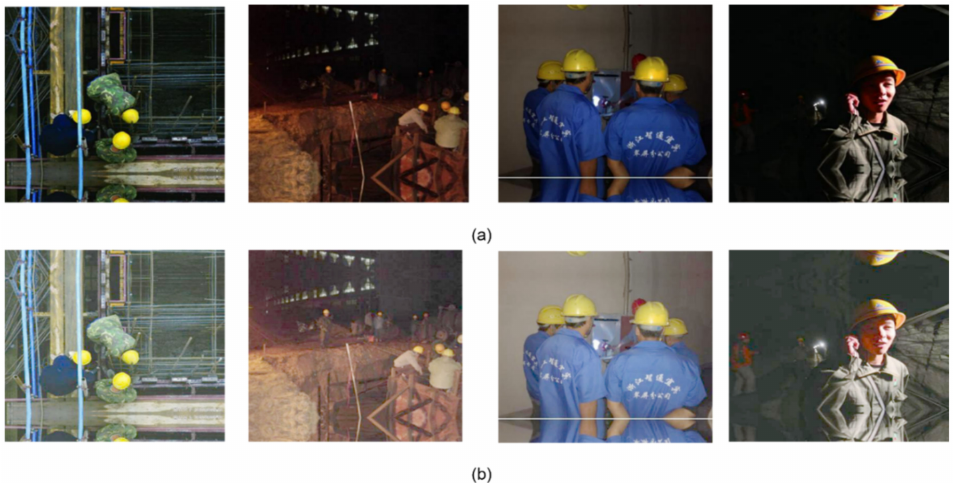
Figure 4. Power-law transformation: ( a ) Original Images ( b ) Enhanced Images.